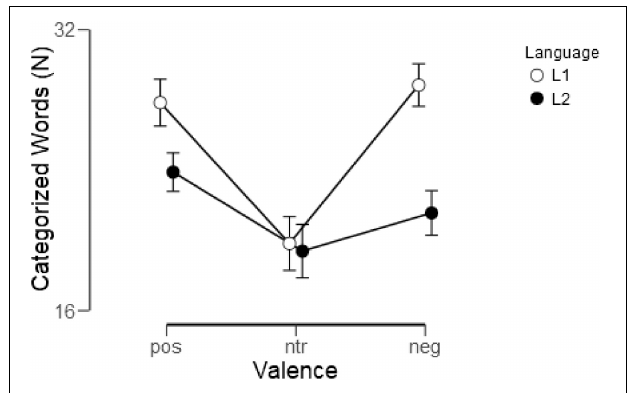
FIGURE 1 | Assignment of words to the positive (pos), neutral (ntr), and negative (neg) valence categories in L1 (German) and L2 (English). Shown are means and standard errors.